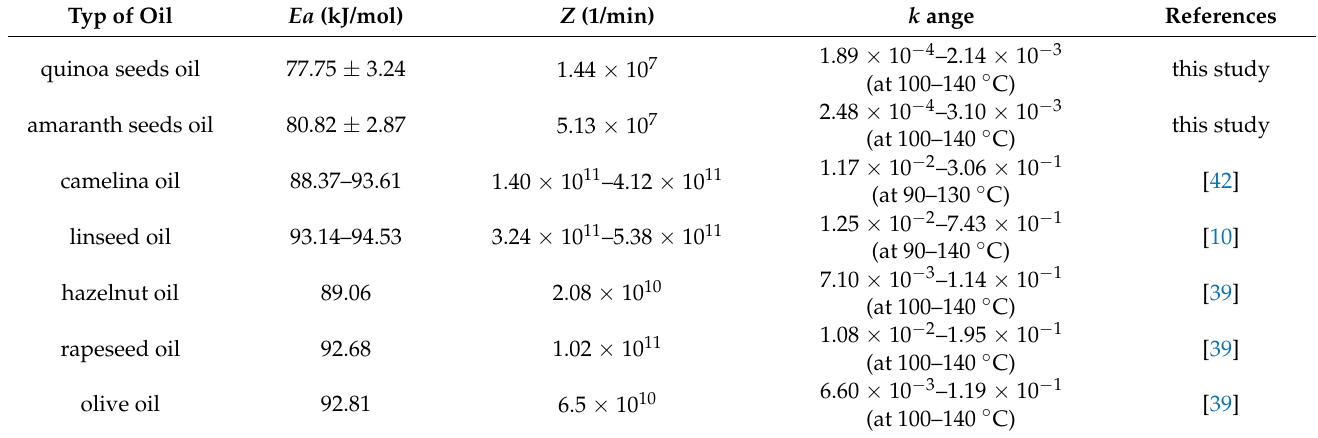
Data denoted by the same letter are not statistically different ( α = 0.05). Table 5. Comparison of oxidation parameters (activation energy— Ea , pre-exponential factor— Z , and reaction rate coefficient— k ) of pseudo-cereal oils with camelina, linseed, hazelnut, rapeseed and olive